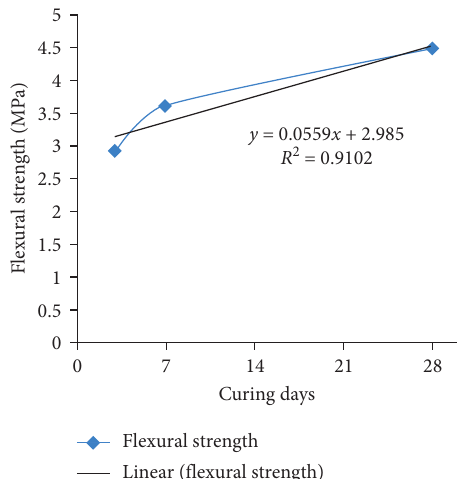
Figure 7: Temporal variations in compressive strength of treated effluent imbibed concrete block.